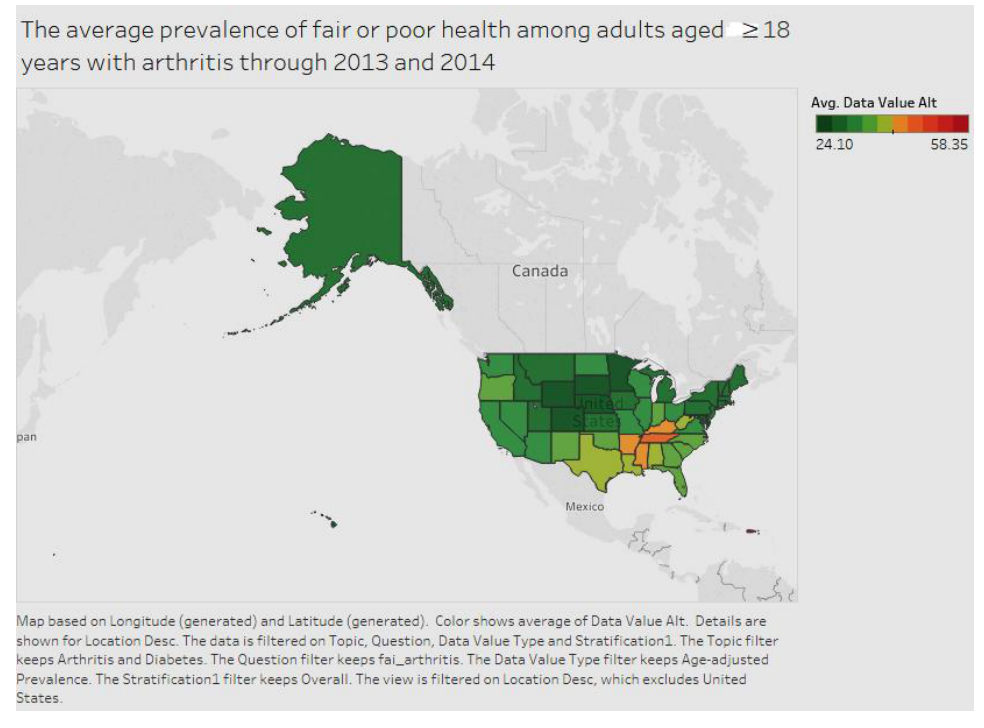
Figure 2. Arthritis by state.